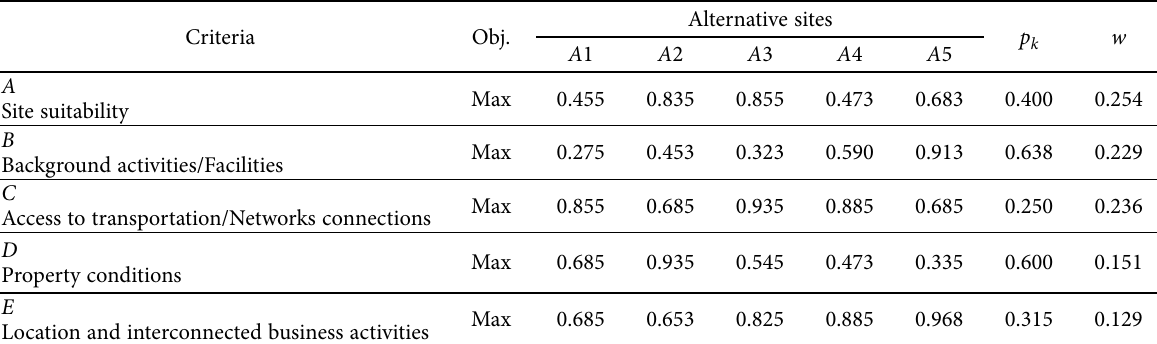
Table 7. Defuzzified PROMETHEE criteria evaluation